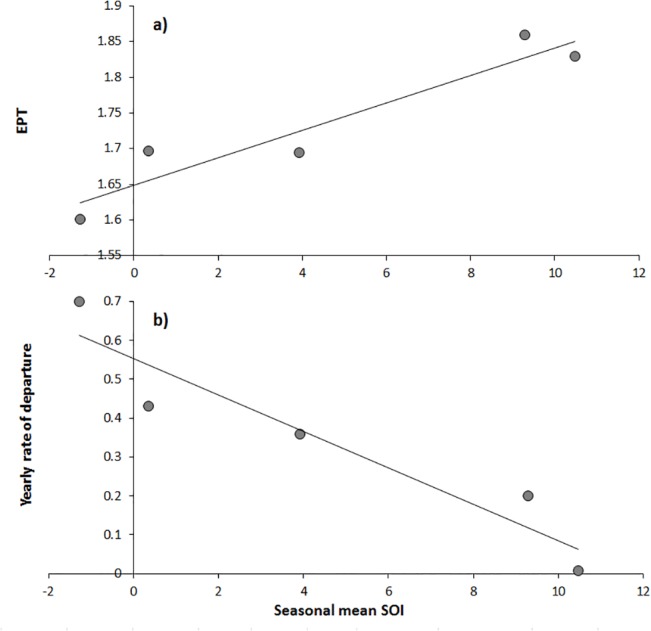
Relationships between yearly rate of departure from the aggregation and encounters per trip (EPT), and the seasonal mean Southern Oscillation Index (days between encounters).Slope = 0.05SST + 0.55, R2 = 0.89, p = 0.015 and EPT = -0.02SOI +1.65, R2 = 0.90, p = 0.014.